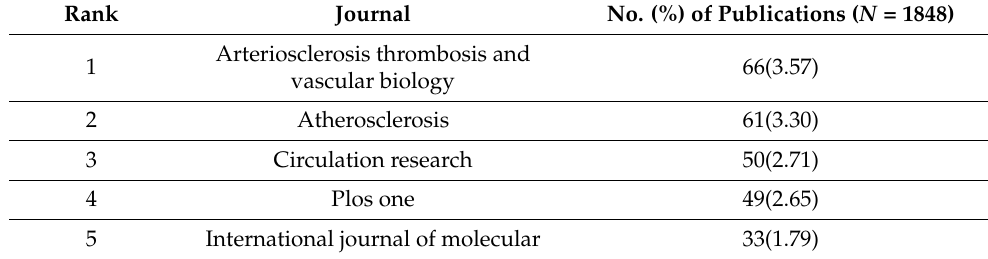
Table 2. The top five